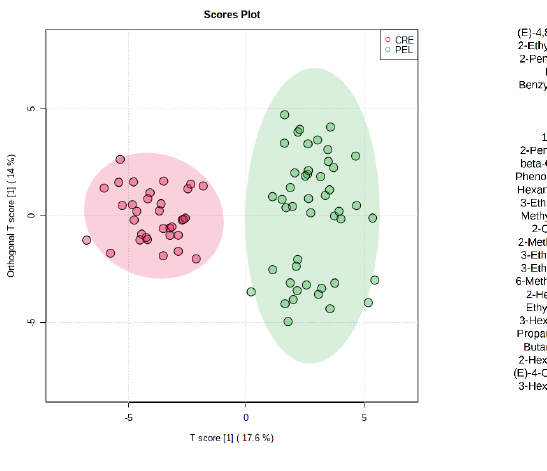
Figure 6. ( a ) ROC curves from the combination of the potential biomarkers for the cross − validation (blue — CV) and external validation set (pink — hold-out). ( b ) Plot of the average predicted class probabilities for each olive oil sample from the Peloponnese (solid dots) and Crete (open dots). The red dots (solid and open) denote samples belonging to the external validation set. The classification